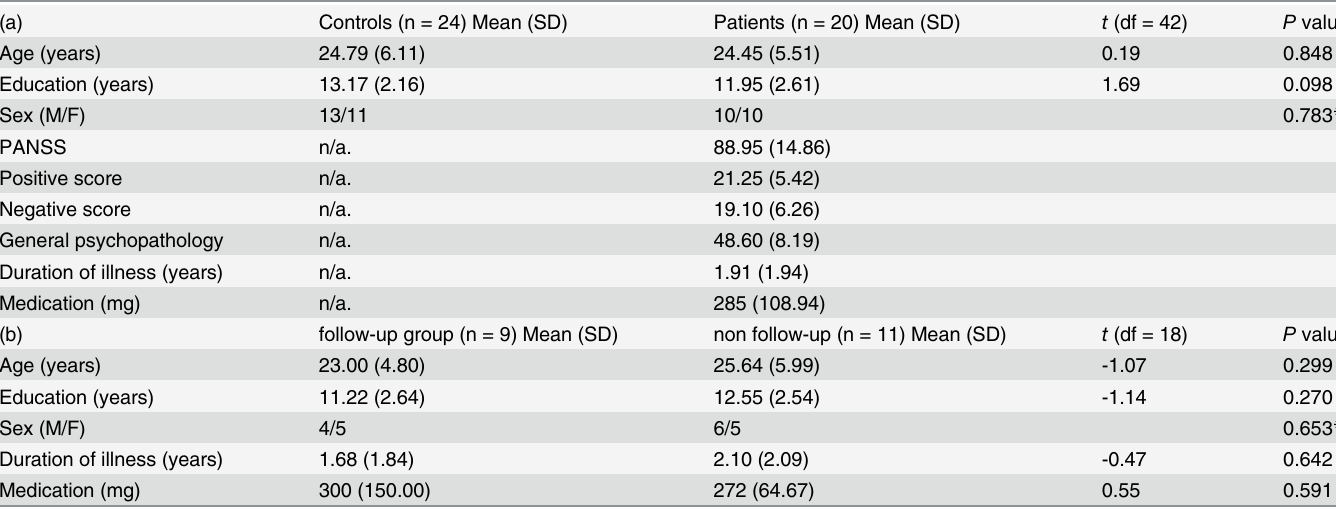
Table 1. Demographic and clinical characteristics of (a) patients group and controls group and (b) follow-up group and non follow-up group.